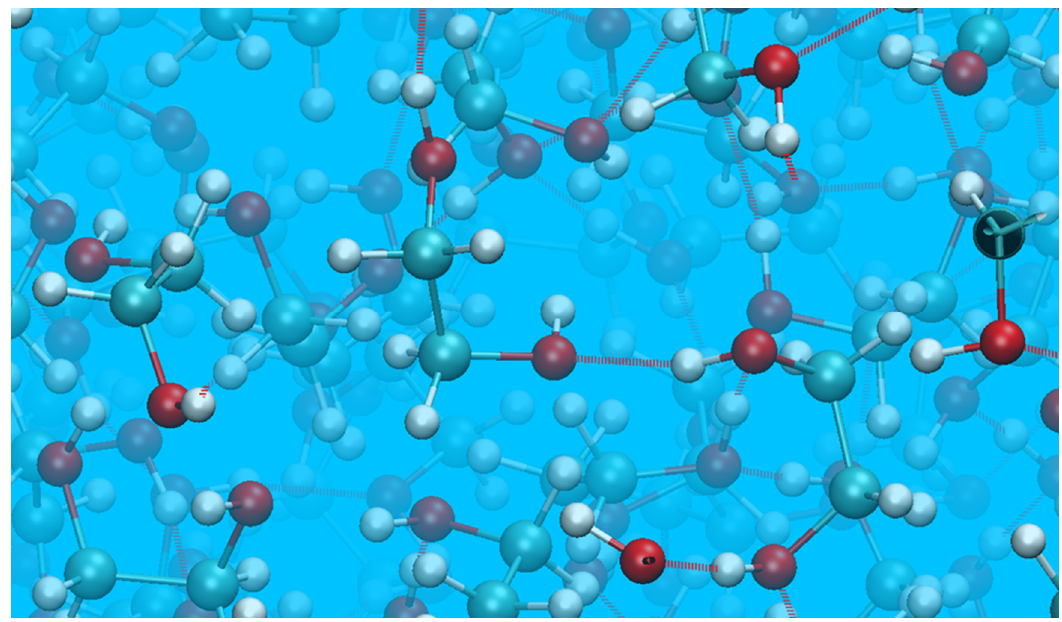
Figure 7. Snapshot of EG MD trajectory, with intermolecular hydrogen bonds interactions highlighted (dashed). The average O(H)···O distance is 2.76 Å.